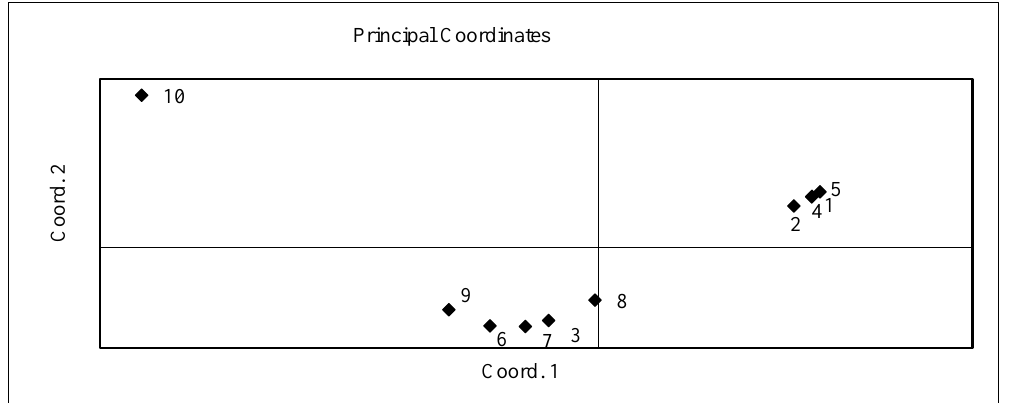
Figure 1. Scatter plot of different basil cultivars according to the results of principled coordinate analysis (PCoA) of plant height and foliage perimeter estimation in 2017 – 2018. Basil cultivars: 1 — Sweet Genovese; 2 — Toscano; 3 — Classic Italiano; 4 — Siam Queen; 5 — Fino Verde; 6 — Cinnamon; 7 — Compact; 8 — Purple Opal; 9 — Rosie; 10 — Holly.